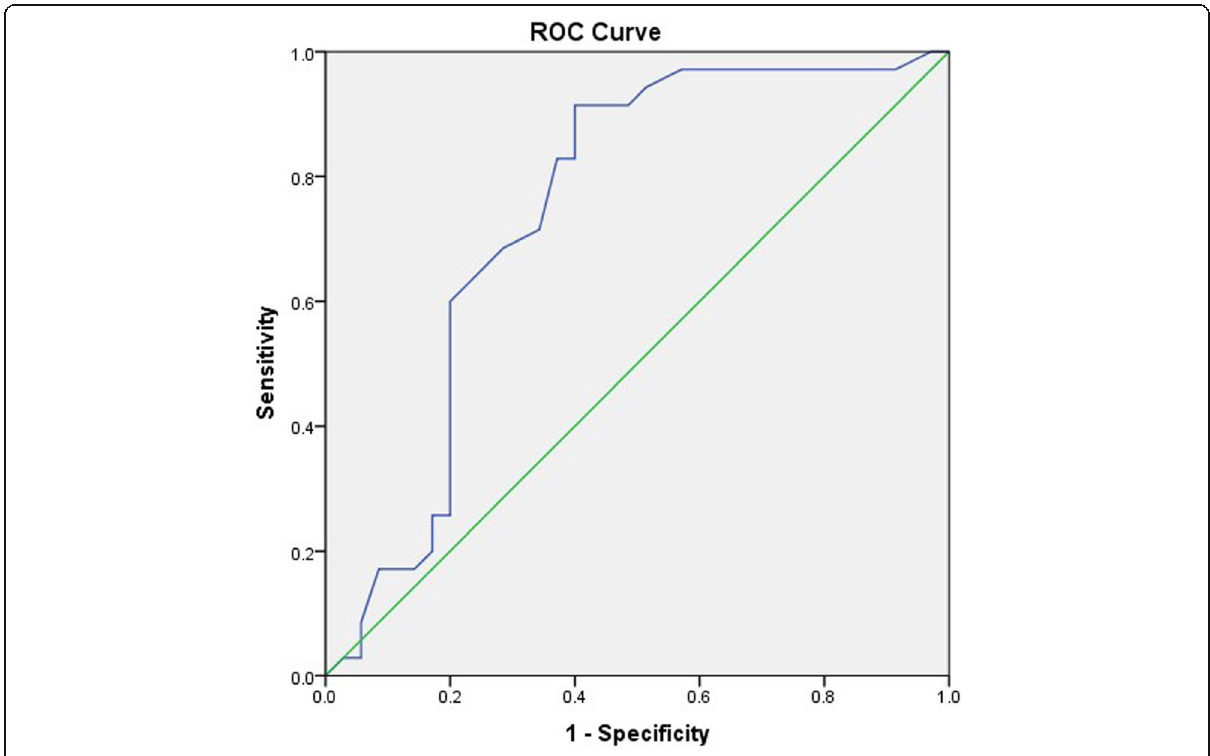
Fig. 2 ROC curve of PTX3 for diagnosis of metabolic